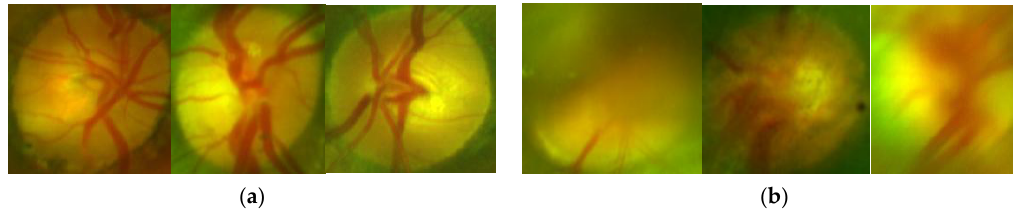
Figure 12. Examples of classification of quality of the OD. ( a ) ODs classified as good-quality, ( b ) ODs classified as bad-quality.